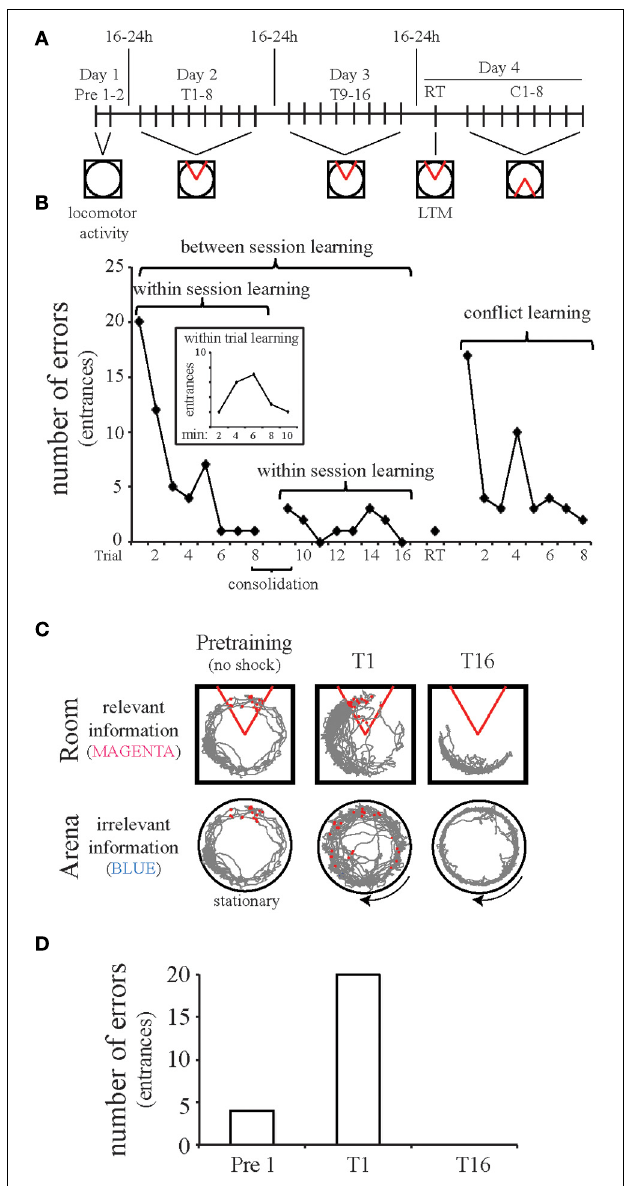
FIGURE 2 | The active place avoidance paradigm is used to study cognitive control. The apparatus consists of an 82-cm diameter disk-shaped arena with transparent walls and extra-arena visual cues placed within the room. (A) Experimental protocol. Pretraining (Pre 1–2), the animal explores the stationary arena, during which time no shock is delivered. To evaluate active place avoidance, the animals are placed on the rotating arena (1rpm) and a mild foot-shock ( ∼ 0.3mA) is delivered for 500ms whenever the rat enters the shock zone, which is a 60 ◦ sector that is defined by the computer in room coordinates. The shock is repeated every 1500ms until the subject leaves the shock zone. Avoidance is measured by counting the number of errors, defined as occasions that the animal enters the shock zone. Animals are trained over the course of several days to study learning, memory retention, and cognitive flexibility. Each trial [training 1–16 (T1–16), retention (RT), and conflict learning (C1–8)] is 10min and the interval between trials is at least 10min. After training for multiple days, cognitive flexibility is assessed during conflict learning after shifting the shock zone 180 ◦ from the original location. (B) Behavior of